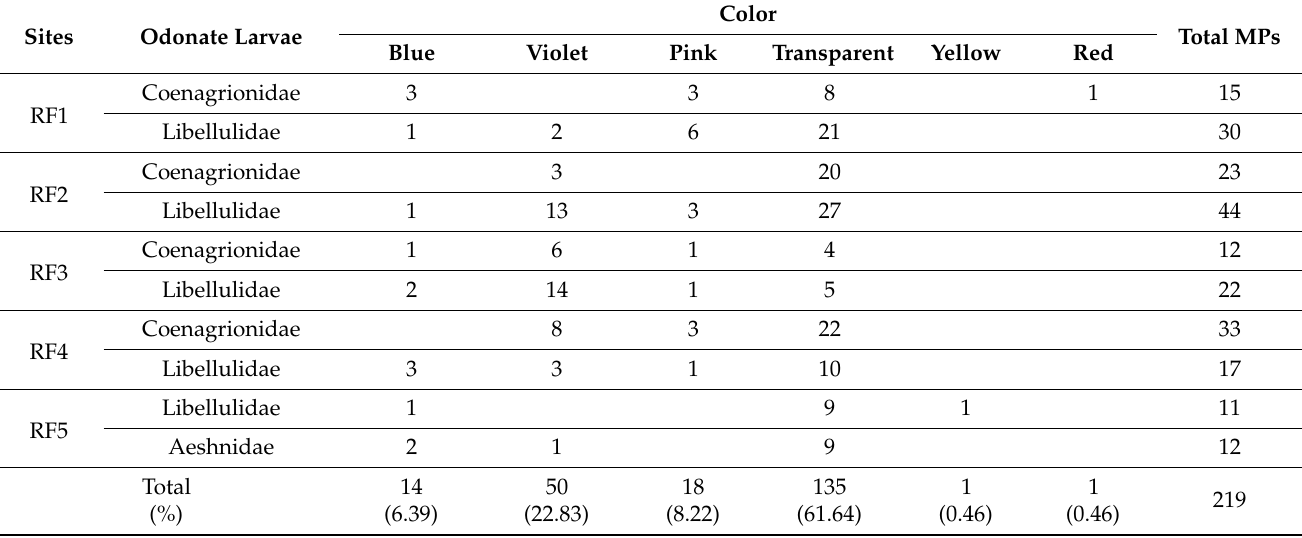
Table 6. Color distribution of microplastics in odonate larvae from rice